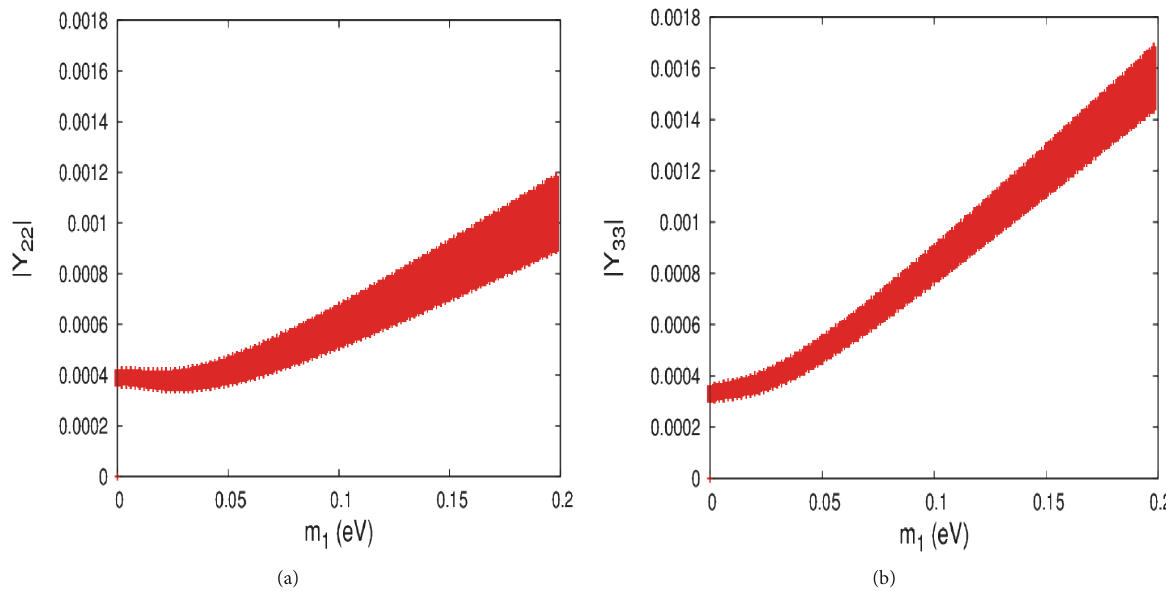
Figure 3: Determination of moduli of 𝑌 matrix elements within 1𝜎 uncertainty of oscillation data as a function of lightest neutrino mass eigenvalues 𝑚 1 as shown in (a) for |𝑌 22 | , and in (b) for |𝑌 33 | . Phase angles used are the same as in Figure 2.